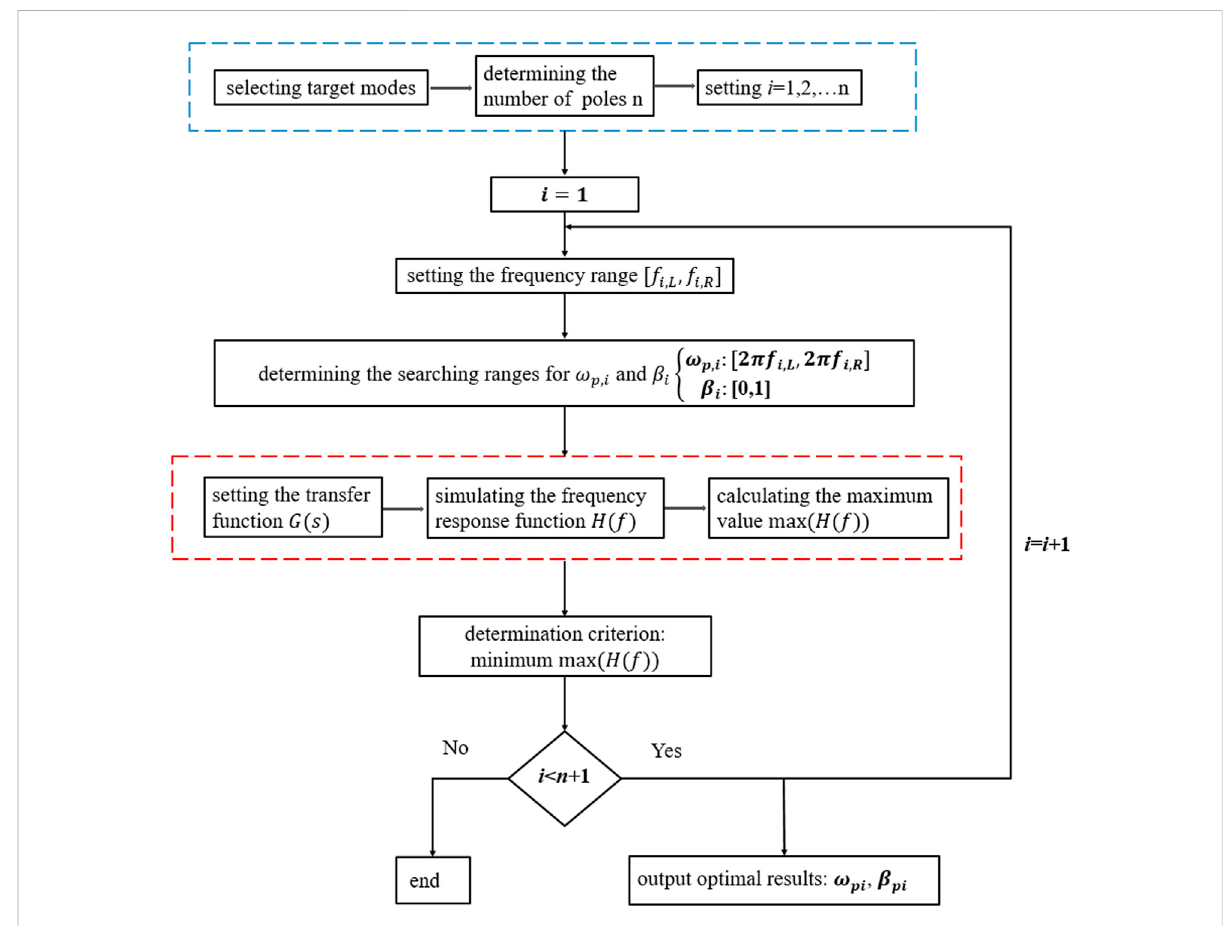
FIGURE 2 Flow chart of the optimization algorithm to calculate the optimal electrical